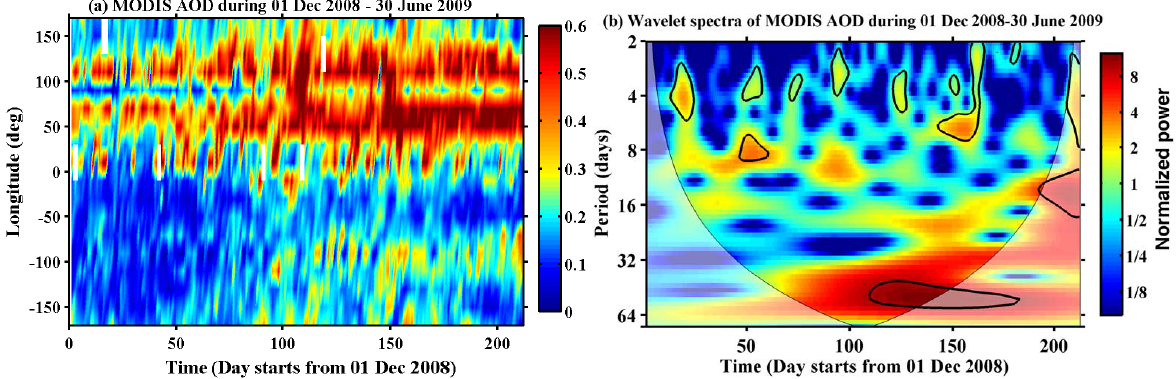
Fig. 2. (a) Time–longitude section of MODIS AOD data obtained during December 2008–June 2009 for 550nm. (b) Wavelet spectra plotted as a function of day number (starting from 1 December 2008) for 550nm. White patches represent data gaps. Contours in the wavelet spectra represent 90% confidence level.